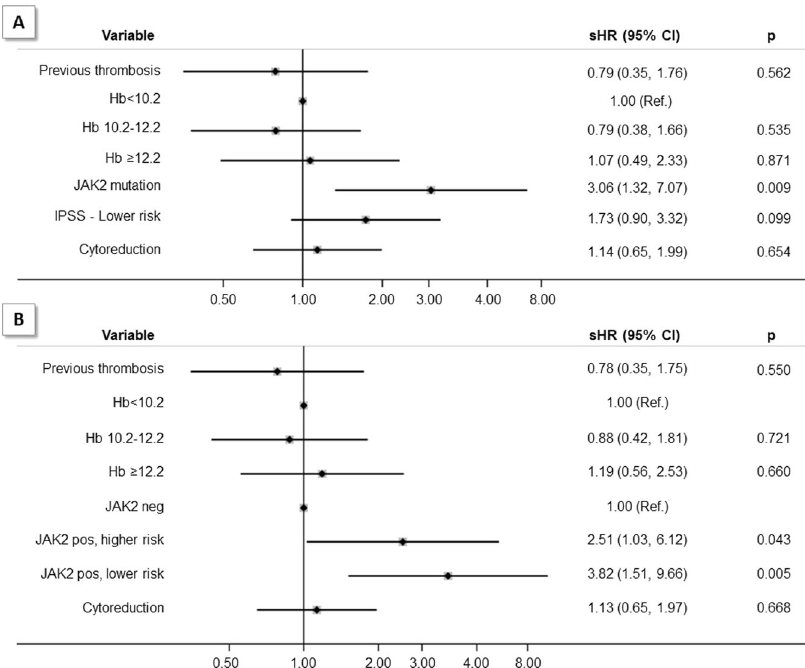
Fig. 1 Predictors of post-diagnosis thrombosis estimated by a multivariable Fine and Gray ’ s competing risk model adjusted for potential confounders (death was considered as a competing event). sHR Sub-distribution Hazard Ratio, CI Con fi dence Interval. Hb Hemoglobin (g/dl). JAK2 pos, higher risk: patients with the combination JAK2 V617F mutated and intermediate-2/high IPSS. JAK2 pos, lower risk: patients with the combination JAK2 V617F mutated and low/intermediate -1